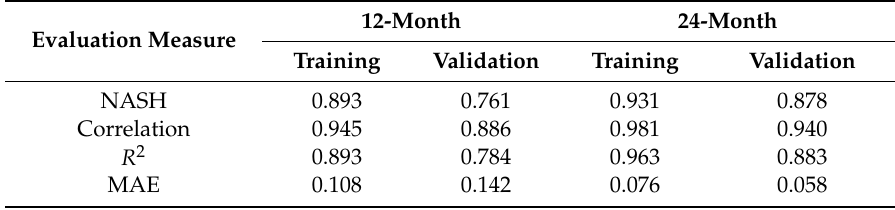
Table 2. Statistical evaluation measures for the 12- and 24-month drought forecast models.